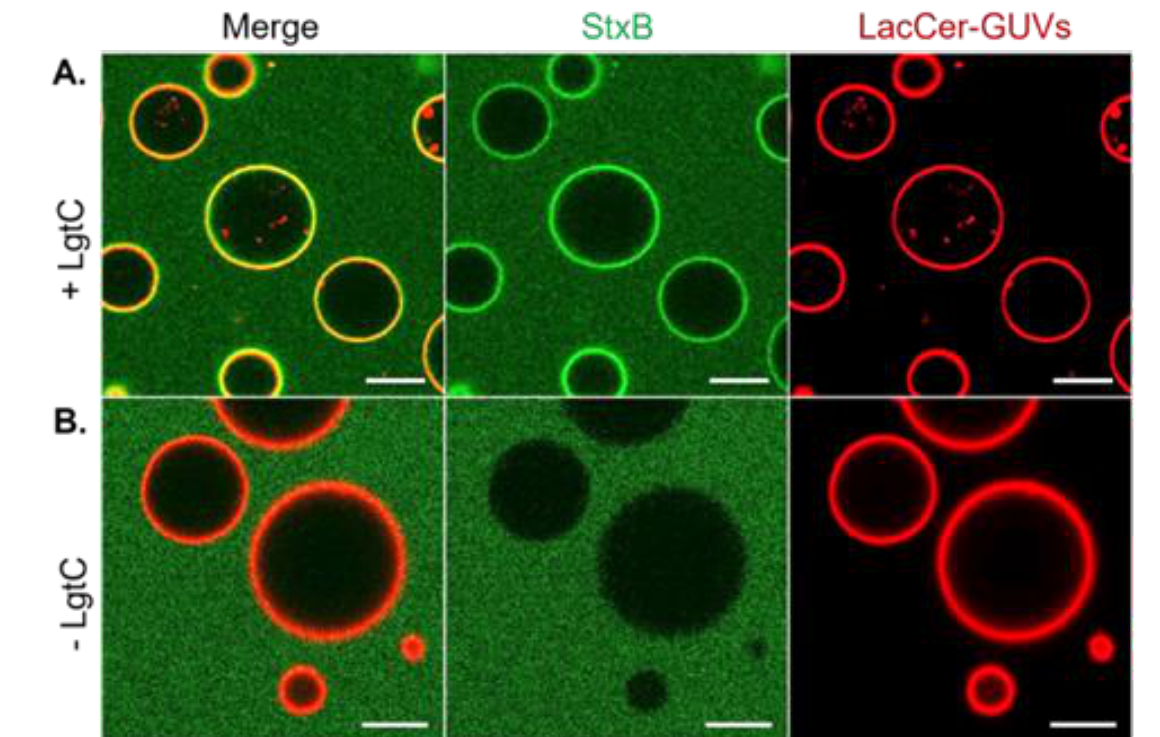
Figure 3. LgtC activity on LacCer-containing GUVs. Confocal images with GUVs visualized via the membrane marker Atto647N-DOPE (red), and Gb3 via StxB-AF488 (green) binding. ( A ) GUVs incubated with LgtC and UDP-Gal. Reaction conditions: 20 mM HEPES, pH 7.4, 1 mM MnCl 2 , 1 mM DTT, 100 ng/μL (2.9 μM) LgtC, 500 μM UDP -Gal and 40 mol-% LacCer-GUVs, incubation time 1 h at RT. Gb3 formation visualized by 500 nM StxB-AF488. ( B ) Negative control, without LgtC. Scale bars: 10 μm.